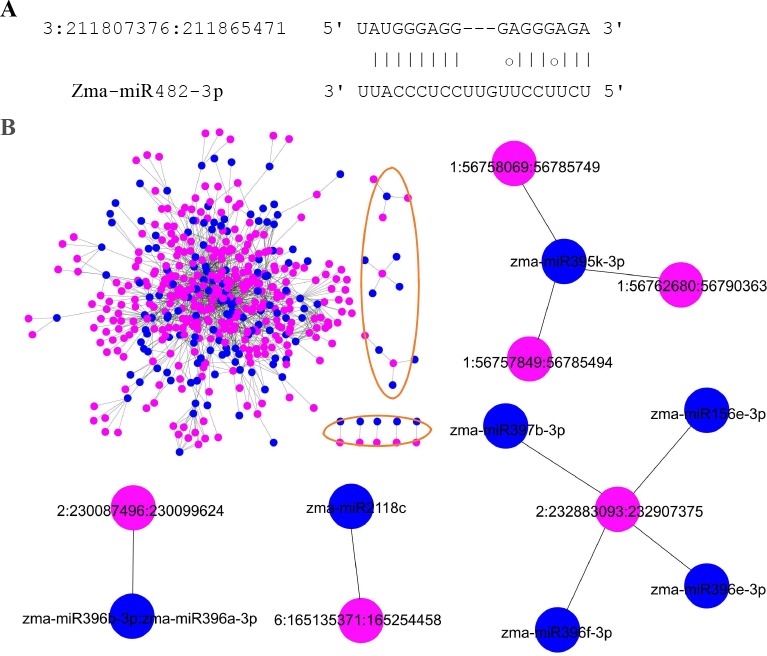
circRNAs acting as miRNA decoys.(A) Binding sites between a circRNA and the corresponding miRNA. (B) The circRNA-miRNA regulatory network. The single network was marked by orange circle. Representative single network were extracted from the integral network. Pink nodes represent circRNAs and blue nodes represent miRNAs. The edges represent connected nodes that exist as a correlation.